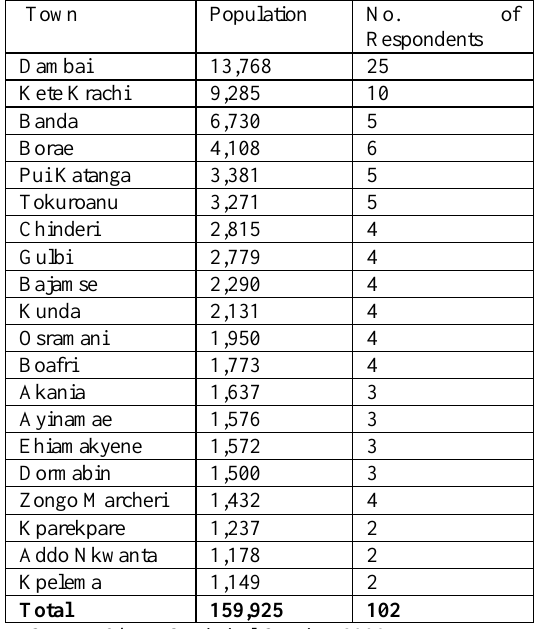
Table 1: Number of Respondents Selected for the Questionnaire